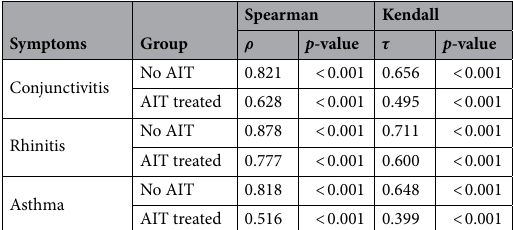
Table 5. Results of the correlation tests the number of symptoms and drug consumption: values of Spearman’s ( ρ ) and Kendall’s ( τ ) rank correlation coefficients and their significance.